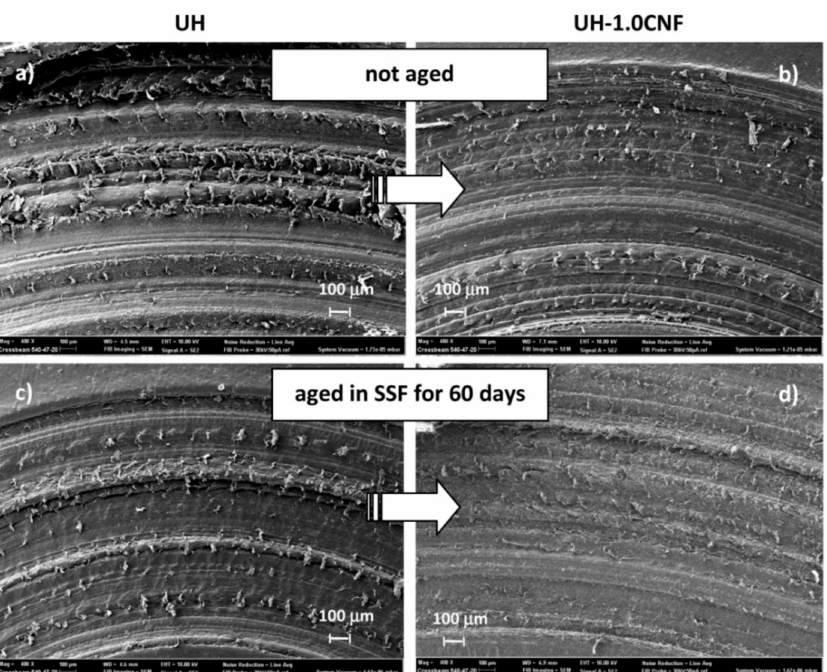
Figure 3. SEM micrographs at 400 × of wear tack of UH ( left ) and UH-1.0 CNF ( right ) before ( a ), and after 60 ( b ) days of immersion in SSF.